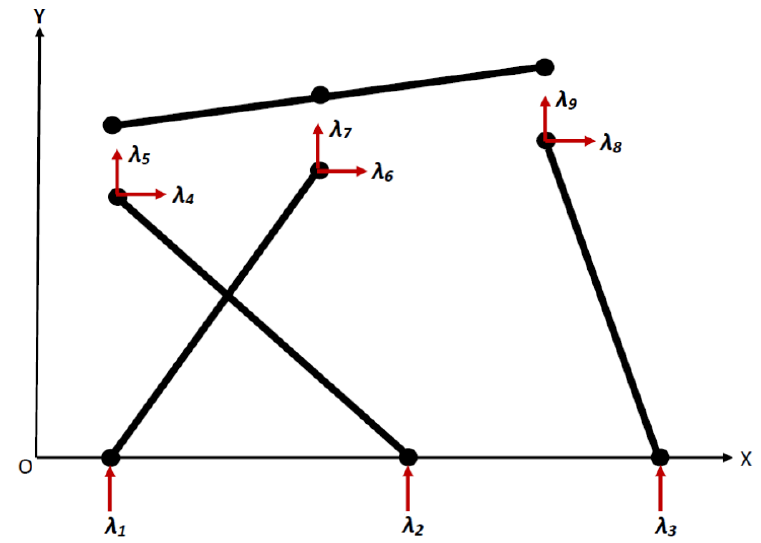
Figure 3. Joint reaction forces corresponding to the Lagrange multipliers.